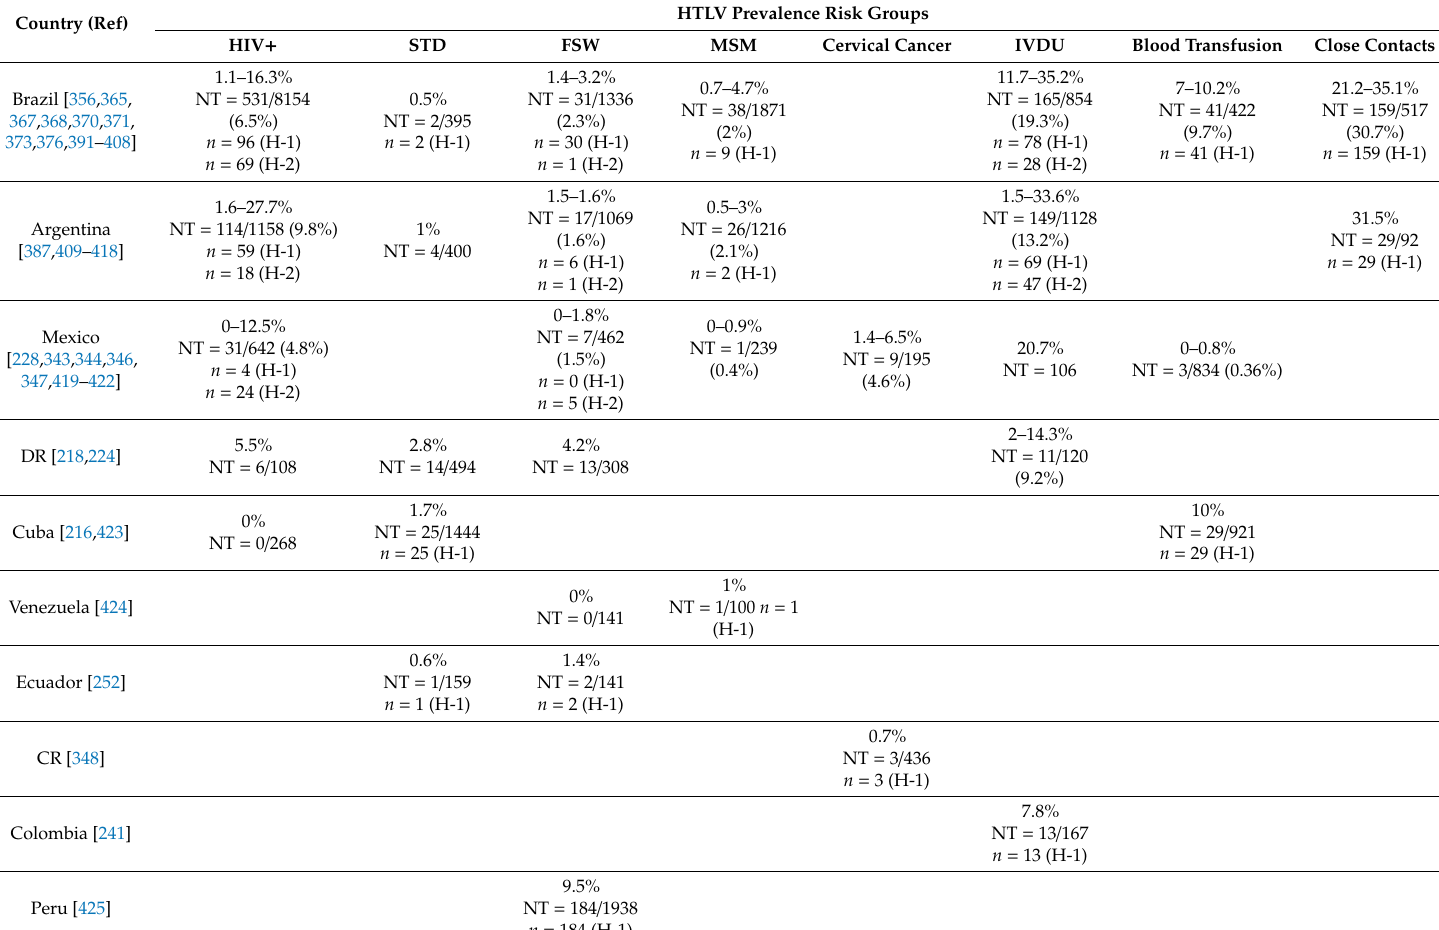
Table 5. HTLV in risk